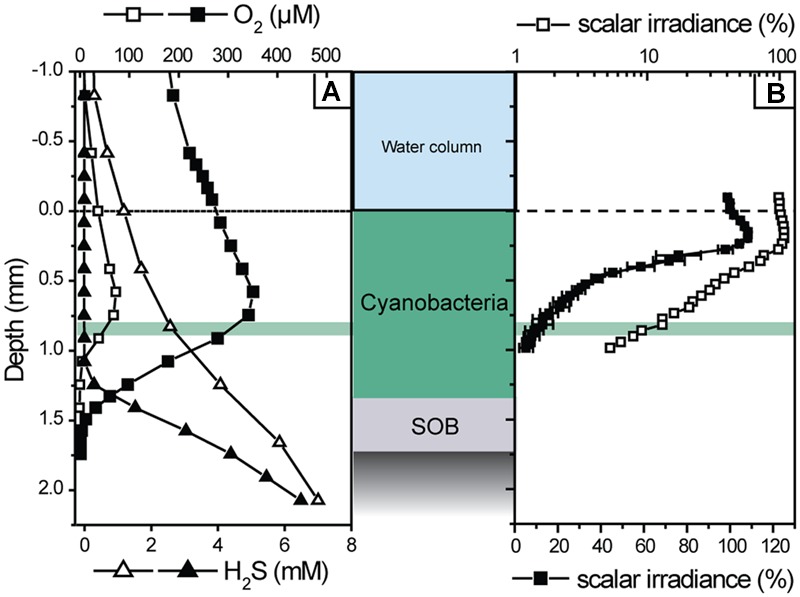
Examples of transient depth profiles of O2 and H2S concentration (A), and of a depth profile of scalar irradiance (B), measured in the cyanobacterial mat during illumination at incident irradiance of 169 μmol photons m-2 s-1. The profiles shown with filled symbols were measured about 2 h after those shown by open symbols. The scalar irradiance values in (B) were integrated over the wavelengths of photosynthetically active radiation (400–700 nm) and normalized to the value at the mat surface. Error bars represent the standard deviation of measurements in three replicate spots of the mat. Note that the filled and open symbols show the same profile in linear and logarithmic scale, respectively. The depth of highest photosynthetic activity (0.83 mm) is indicated by the green area.